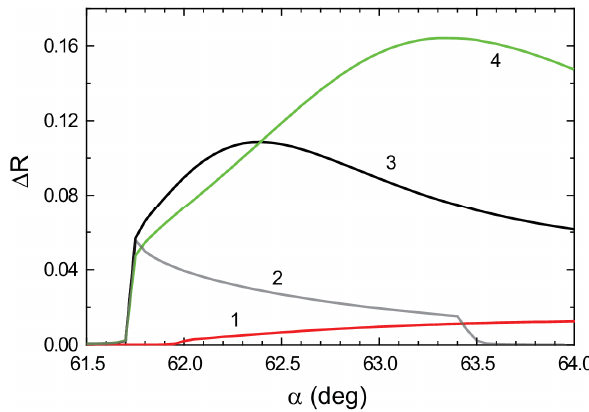
Figure 7. Comparison of the sensors’ optical response upon the change of ∆ n = 1 × 10 − 3 in a 20-nm-thick reaction layer on the surface of the sensors. Lines 1–4 illustrate the vertical sections of Figure 6a–d, respectively: the sections were made for plot (a) D = 24.6 nm; plot (b) ε″ = 0.5 × 10 − 3 ; plot (c) D = 11.1 nm; and plot (d) D = 6.7